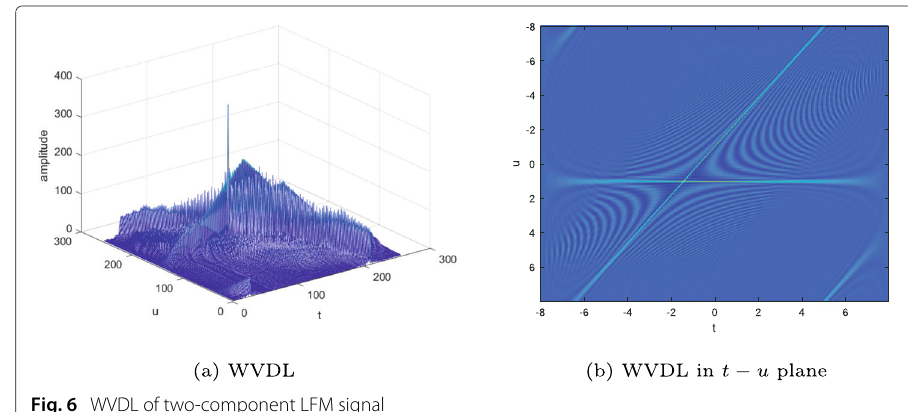
search times are M ; therefore, the computational cost is O ( MN 3 ) . There are search proce- dures for other WVD in LCT domain; their computation become also more complex. For example, unified WVDs associated with LFM have nine or six free parameters, in which burden computation cost have to be faced.